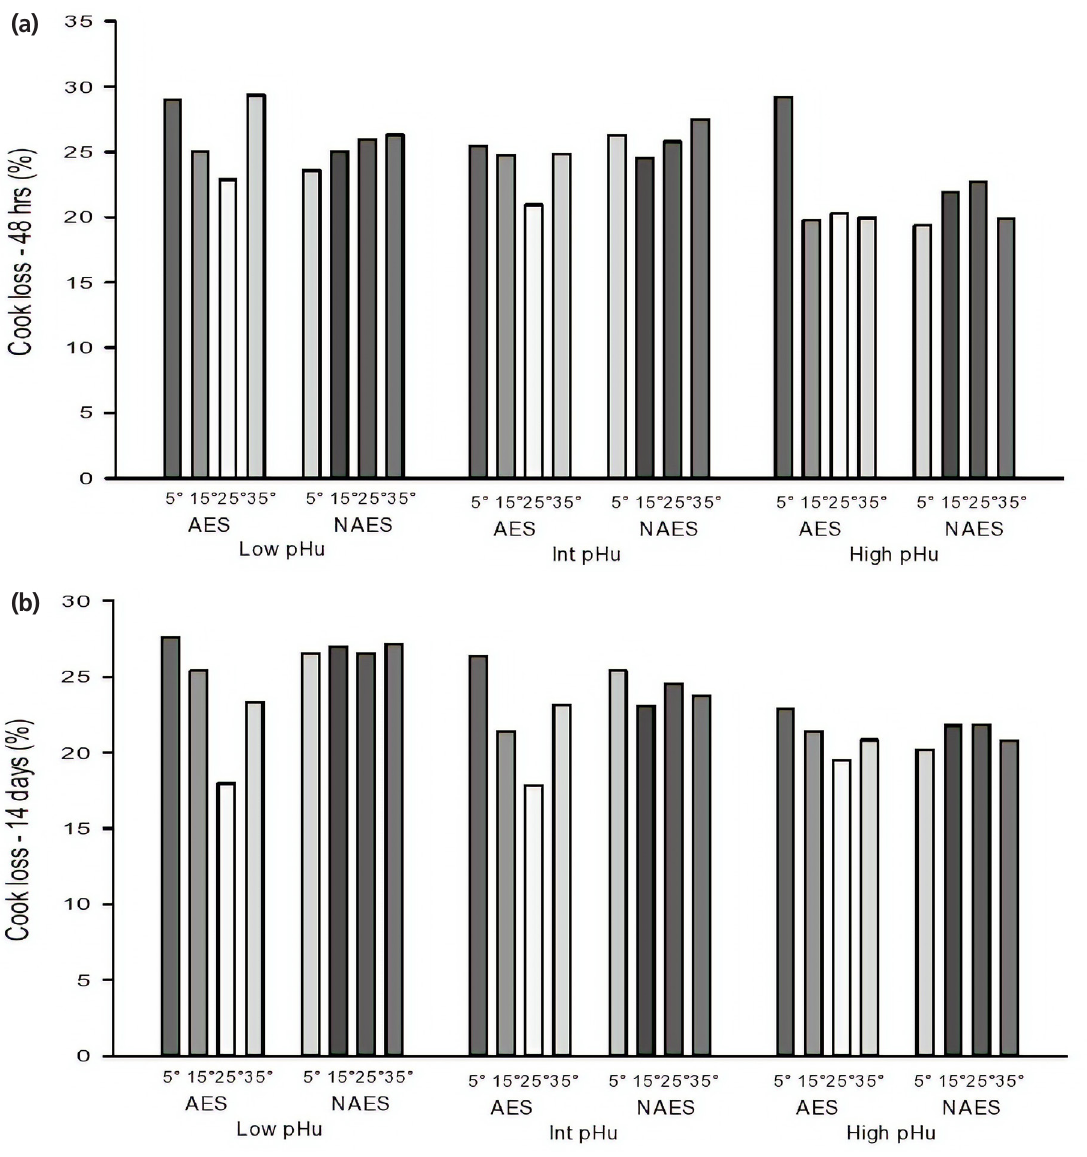
Figure 4. (a) Effect of AES and various pre-rigor holding temperature (for 3 h) methods on cook loss (48 h post mortem) of low, intermediate and high pHu beef M. longissimus lumborum samples. AES, additional electrical stimulation; NAES, no additional electrical stimulation. Low pHu (n = 3), Int (intermediate) pHu (n = 3), and high pHu (n = 6). Treatment effect [AES vs ES] (p>0.05); pH effect (p = 0.008); temperature effect (p = 0.039); Interaction effect (stimulation×temperature) (p<0.001, standard error of difference [SED] = 1.79). (b) Effect of AES and various pre-rigor holding temperature (for 3 h) methods on cook loss (14 days post mortem) of low, intermediate and high pHu beef samples. Low pHu (n = 3), Int (intermediate) pHu (n = 3), and high pHu (n = 6). Treatment effect [AES vs ES] (p>0.05); pH effect (p = 0.05); temperature effect (p>0.05); Interaction effect (stimulation×temperature) (p = 0.015, SED =